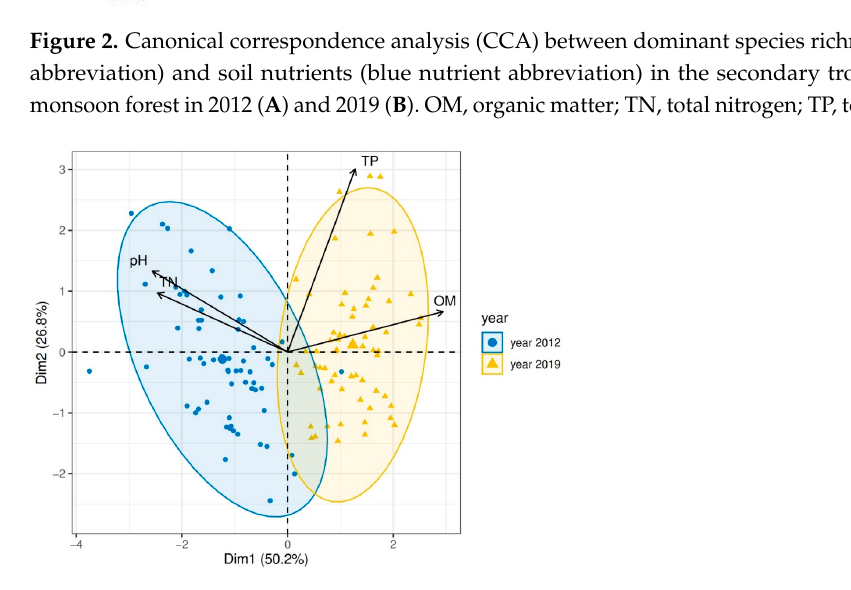
Figure 3. Principal component analysis (PCA) of soil variables in two different years (2012 and 2019). Blue and yellow dots show the sites. pH, soil pH; OM, organic matter; TN, total nitrogen; TP, total phosphorus.